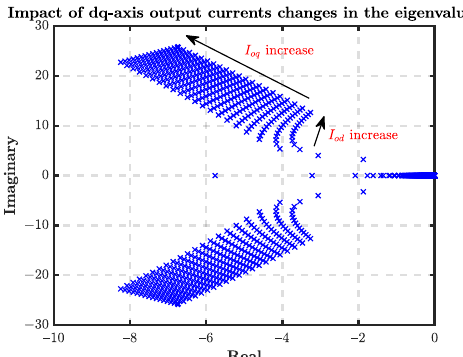
Figure 9. The trace of eigenvalues for 0 ≤ I od ≤ 75 and − 50 ≤ I oq ≤ 50.